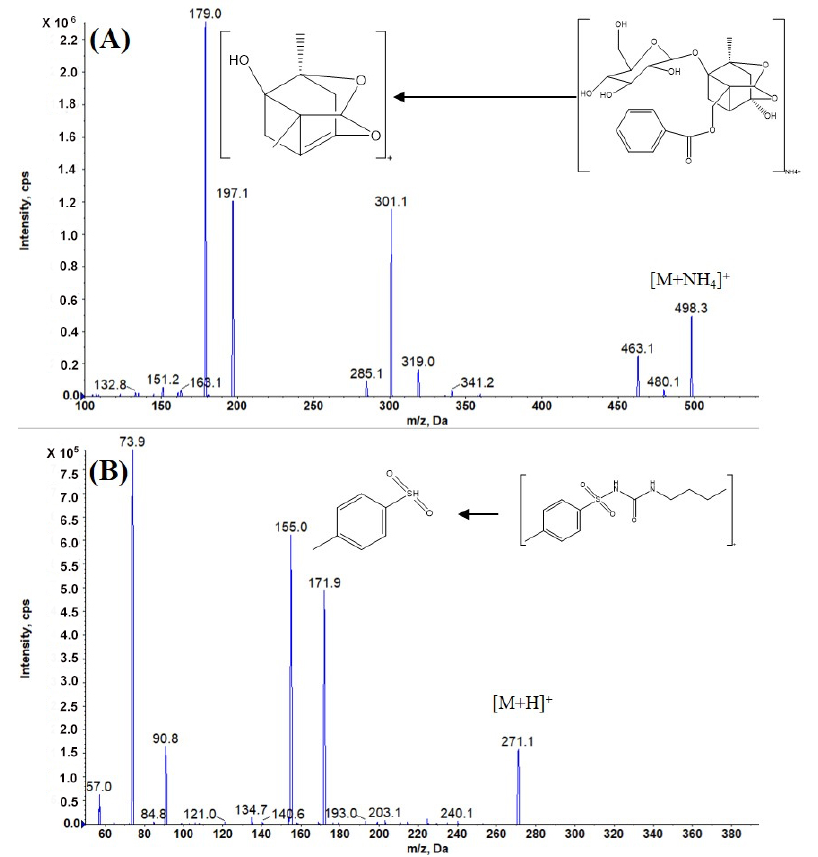
Figure 2. Positive product ion mass spectra of PF ( A ) and IS ( B ) and their proposed fragmentation patterns. Table 1. Mass spectrometric parameters for paeoniflorin and tolbutamide